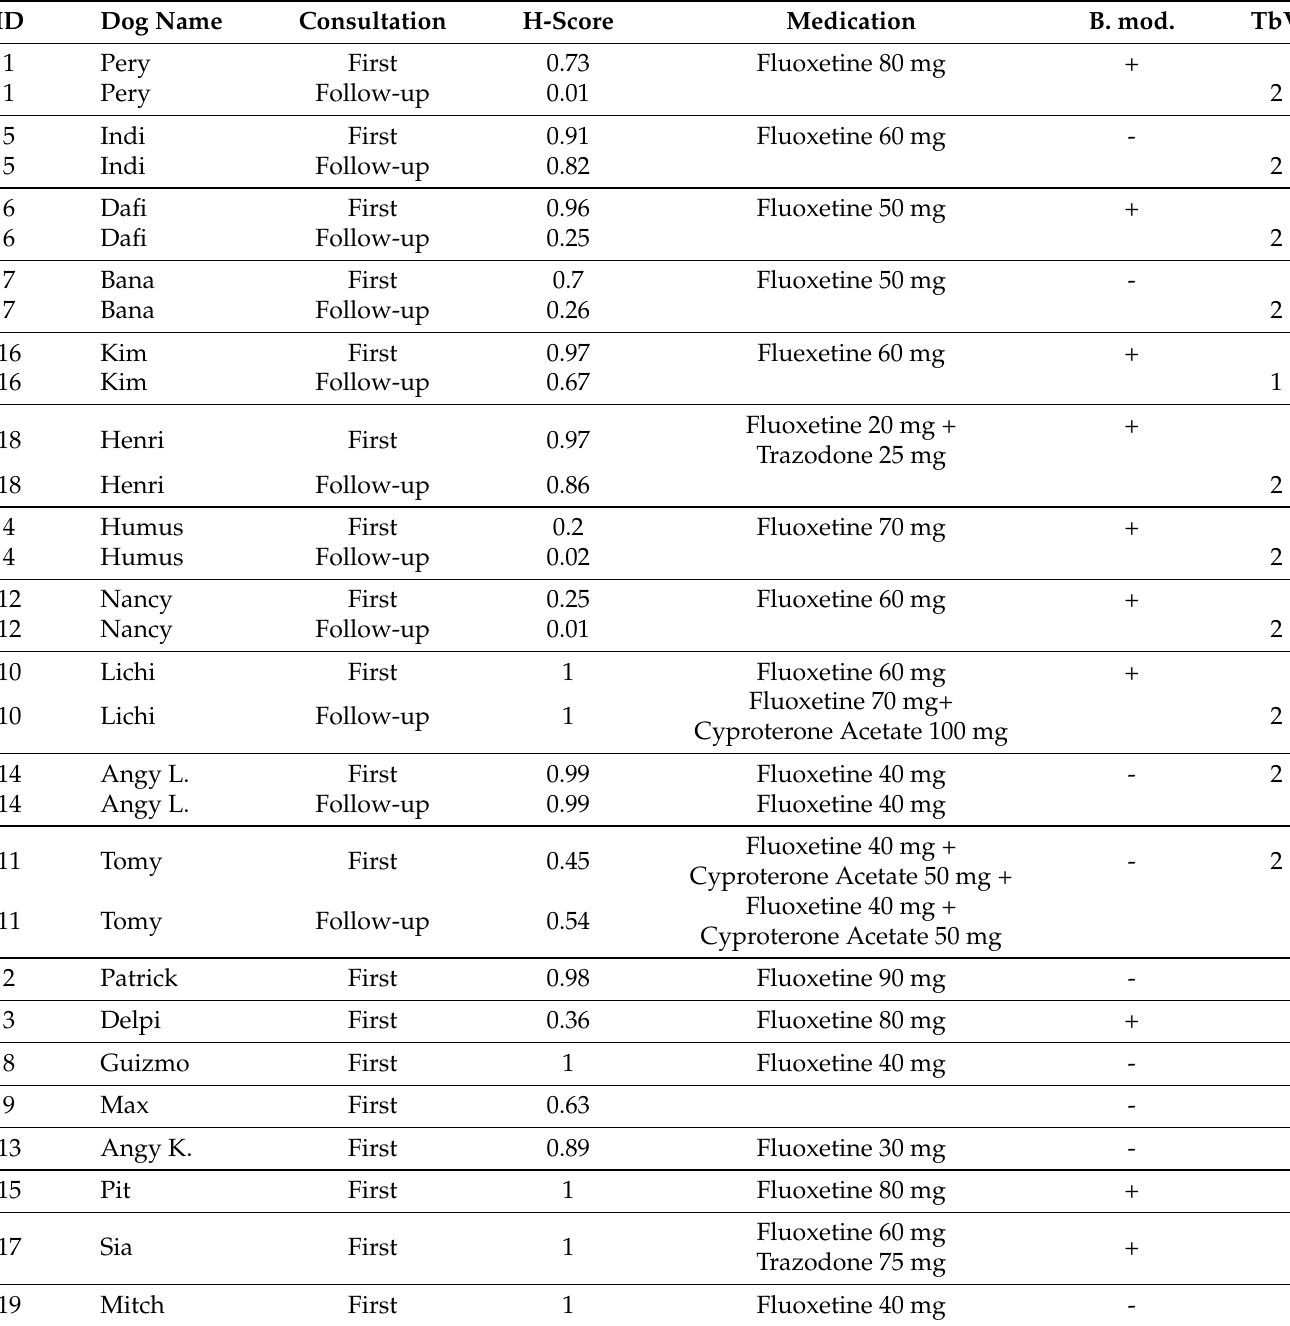
Table 1. H-score of two (first and follow-up) visits of